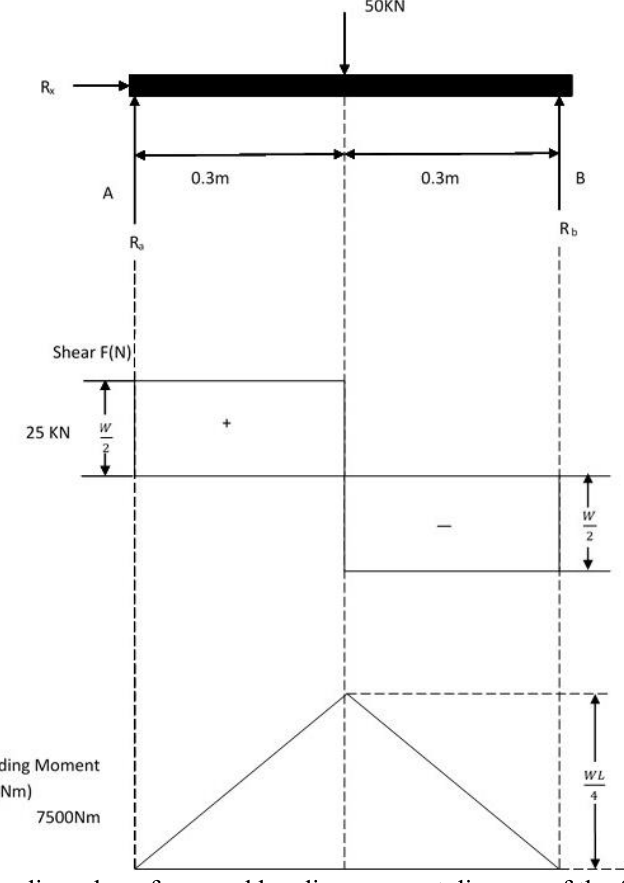
Fig. 4. Loading, shear force and bending moment diagram of the